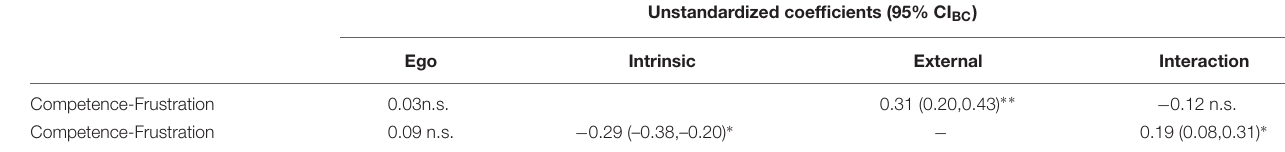
TABLE 3 | Simple moderation for ego goal orientation models.